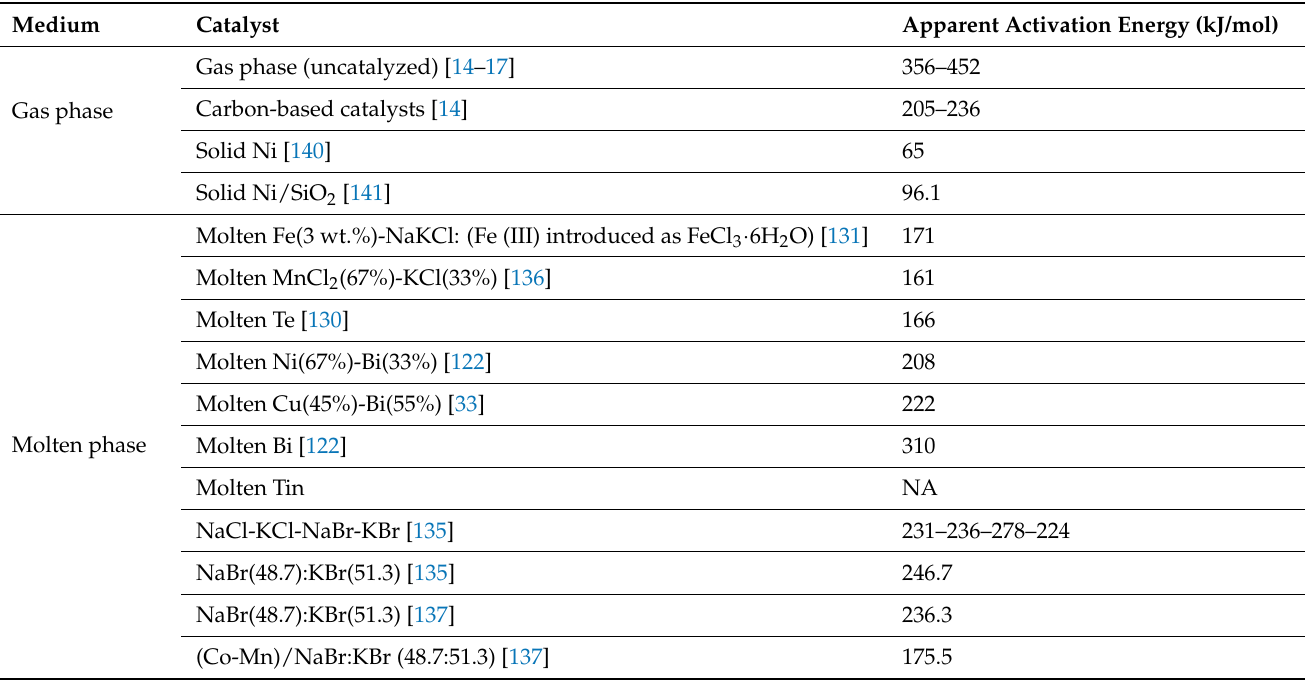
Table 4. Apparent activation energies for different catalysts used in methane pyrolysis